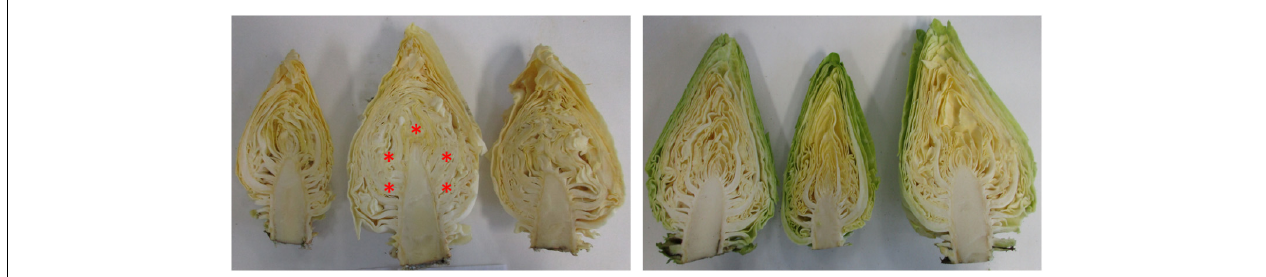
TABLE 2 | Color values measured on the inner surface and soluble solids content (SSC) of juice of white conical cabbages at harvest, 94 dah and 163 dah after storage in different storage regimes. Harvest